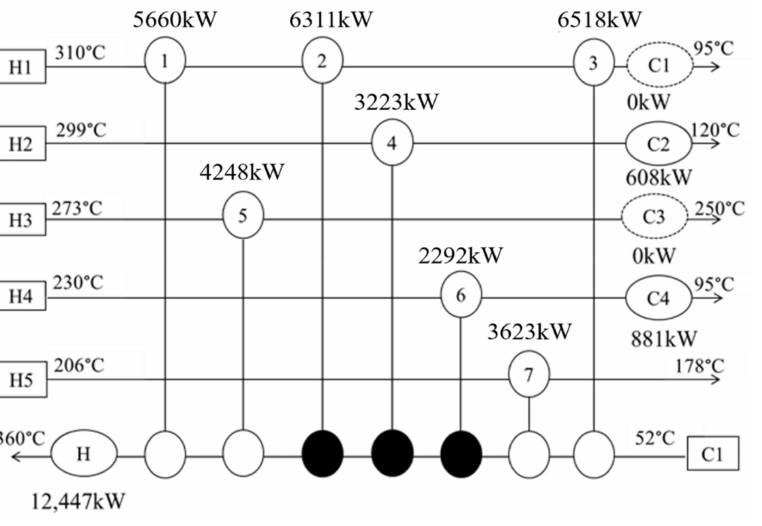
Figure 15. The pinched HEN for case study